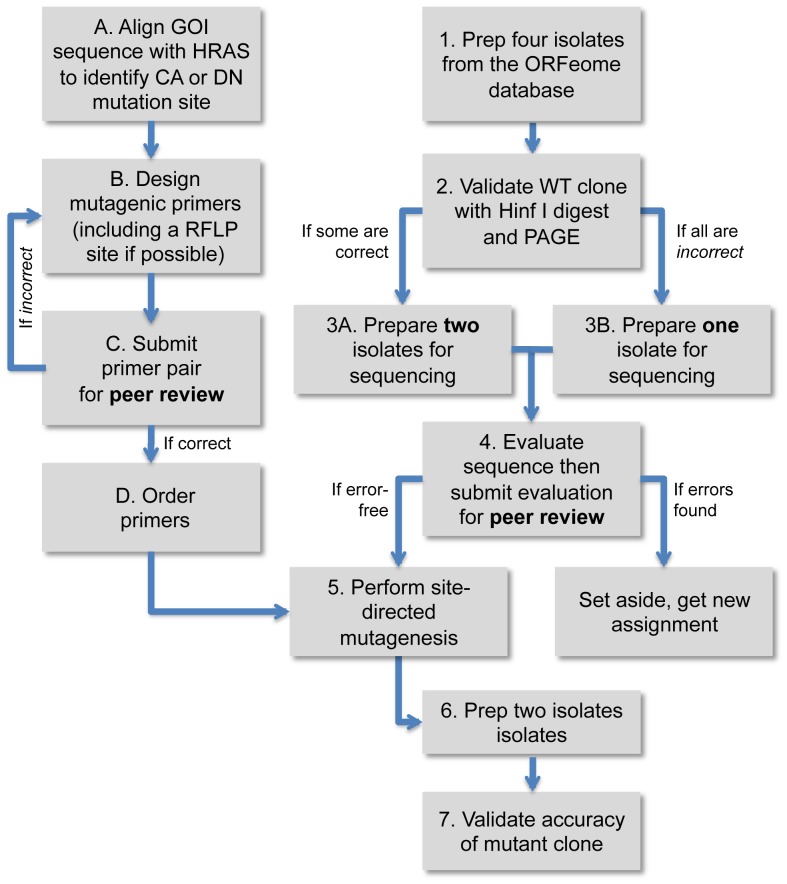
A flow chart describing the lab module involving verification and modification of ORFeome Rab clones.Steps 1 through 4 were done in parallel to steps A through D. Two peer-review steps at 3 and D were included to minimize mistakes in primer design and sequence analysis of WT ORFeome clones. Abbreviations: Gene of Interest (GOI), Constitutive Active (CA), Dominant Negative (DN), Restriction Fragment Length Polymorphism (RLFP), Polyacrylamide Gel Electrophoresis (PAGE), Human Ras (HRAS), Wild-Type (WT).